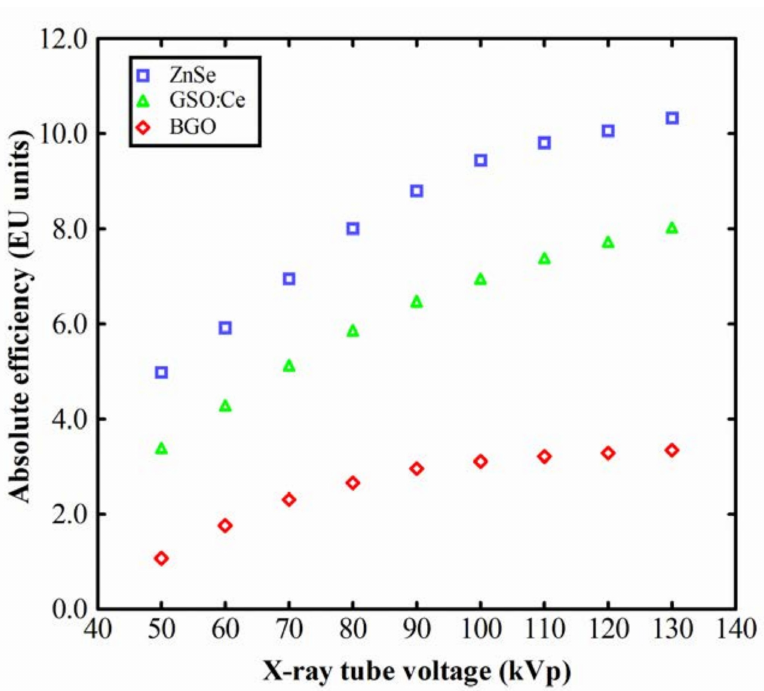
Figure 7. Luminescence e ffi ciency of the ZnSe:Te single crystal. Comparison with BGO and